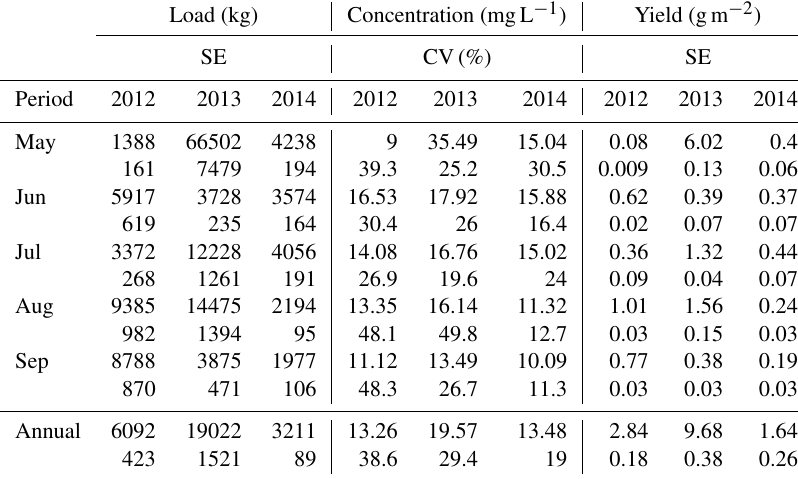
SE and CV indicate standard error and coefficient of variation respectively.